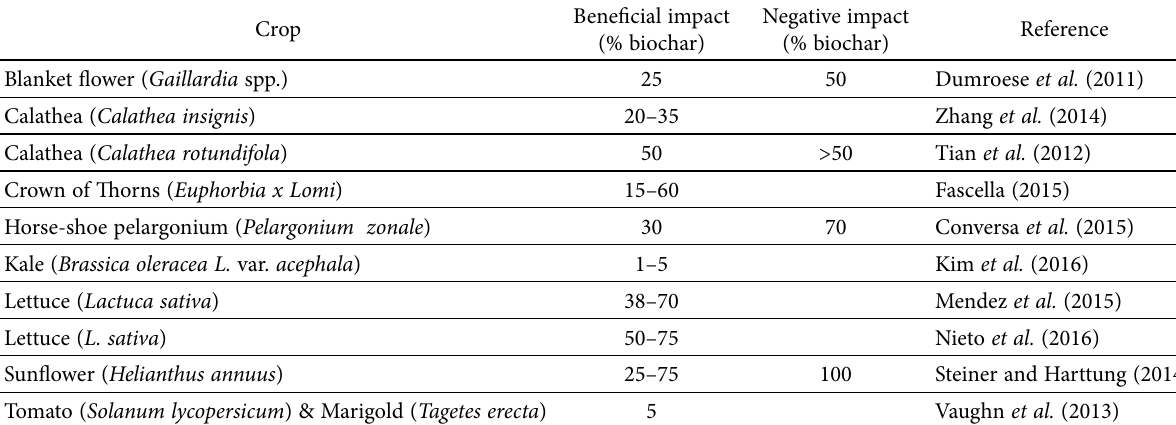
Table 1. List of studies that involve biochar as a peat replacement in soilless media. Data include the range of concentrations in which biochar was found to be beneficial or non-harmful to plant growth are presented in the 2 nd column. Concentrations at which negative effects on plant growth were detected are presented in the 3 rd column Beneficial impact Crop (%